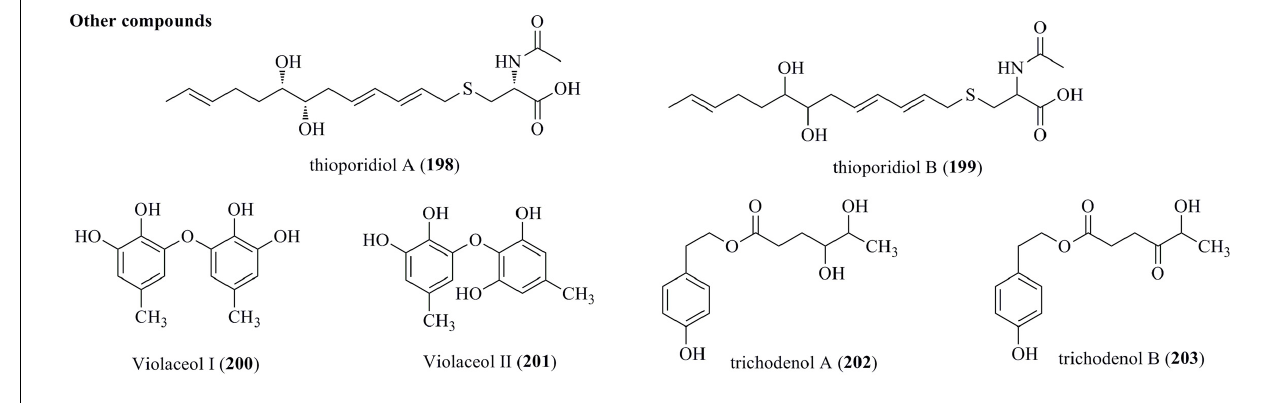
FIGURE 10 | Other compounds produced by Trichoderma species ( 198–203 ).